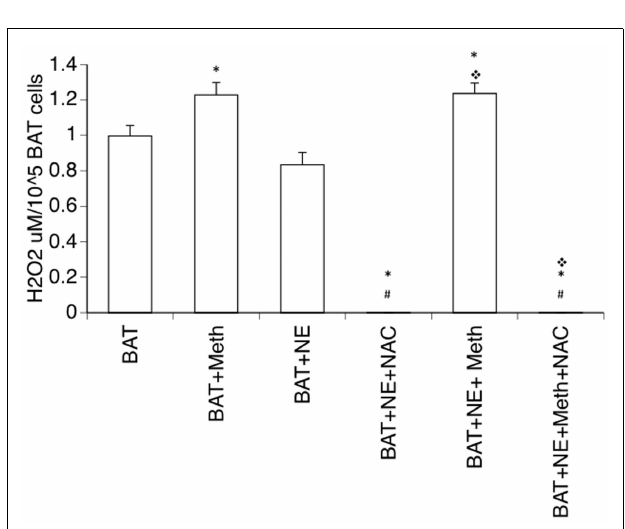
FIGURE 6 |Thermogenesis-related genes in BAT from Meth-injected animals. (A) UCP1 and (B) PGC1alpha transcriptional levels were measured by SyBrGreen qRT-PCR. Relative values were normalized based